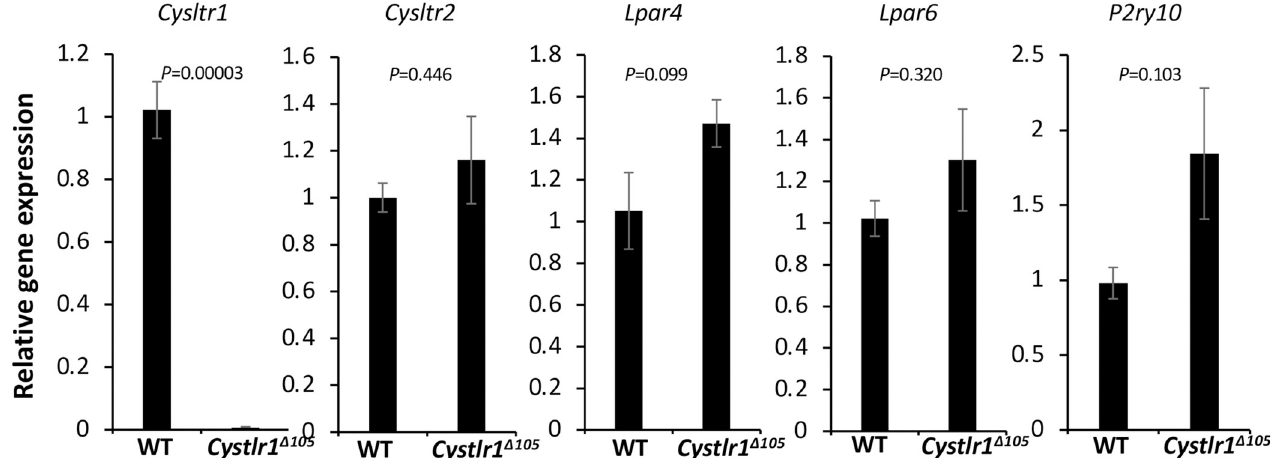
Fig 2. Gene expression of Cysltr1 and its paralogs in bone marrow macrophages of the Cysltr1 Δ 105 mouse. A quantitative PCR analysis was performed for Cysltr1 and its paralog mRNA expression in bone marrow macrophages from WT and Cysltr1 Δ 105 mice. WT, n = 4; Cysltr1 Δ 105 , n = 4. Gene expression was normalized with Rn18s